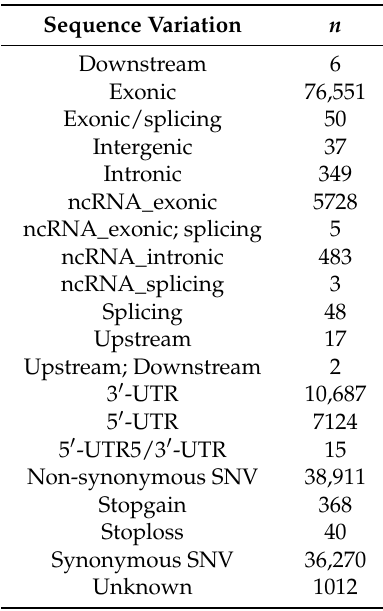
Figure 2. ( A ) Quantile-quantile (QQ)-plot of p -values for common variation observed in patients against 1000G-IBS controls. The green shadow indicates the p -values obtained under a permutation approach (1000 permutations). ( B ) Manhattan plot of common variants observed in patients against 1000G-IBS controls. The dotted line indicates the Bonferroni threshold. Table 2. Description of sequence variants found in the exomes of our patients